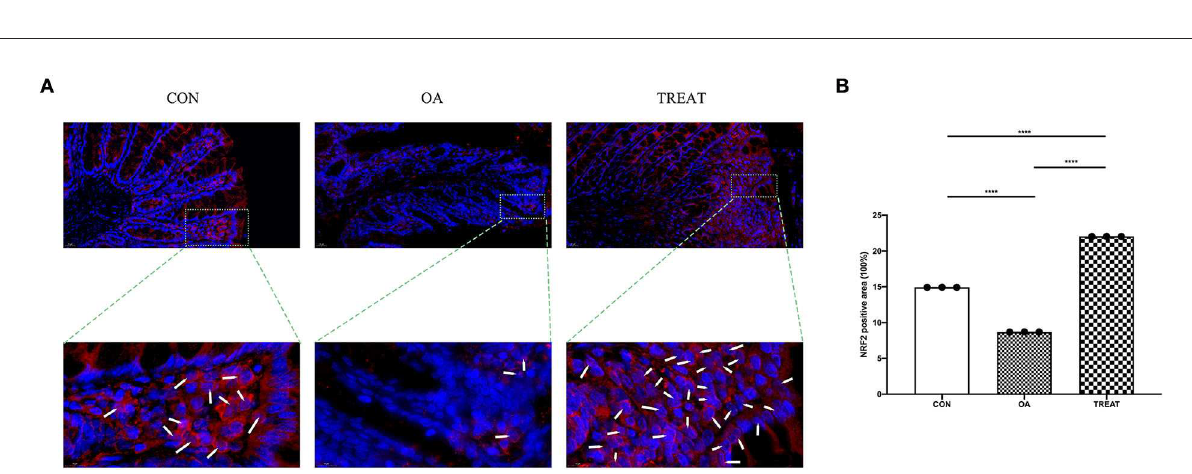
FIGURE7 Effect of the oral administration of live combined Bacillus subtilis and Enterococcus faecium on the OA colonic protein expression of Nrf2 measured via immunofluorescence. Representative photomicrographs are at 400 × magnification. The magnified parts are 1,600 × magnification. (A) Immunofluorescence staining. White arrows indicate Nrf2 entering the nucleus. (B) Positive-stained are for Nrf2. Data are expressed as the mean ± SD. **** p < 0.001. n = 3.